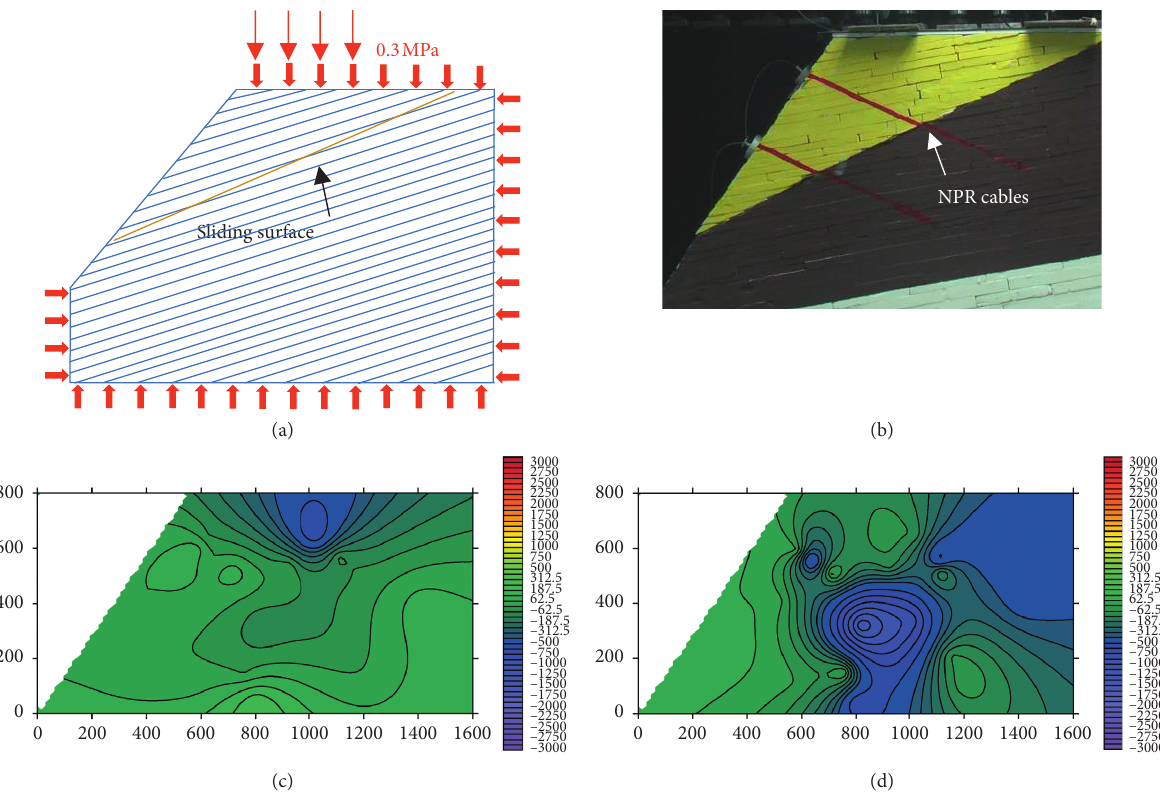
Figure 14: First loading stage stable strain cloud map. (a) Model loading diagram. (b) Model loading variation diagram. (c) X-directional strain cloud map. (d) Y-directional strain cloud